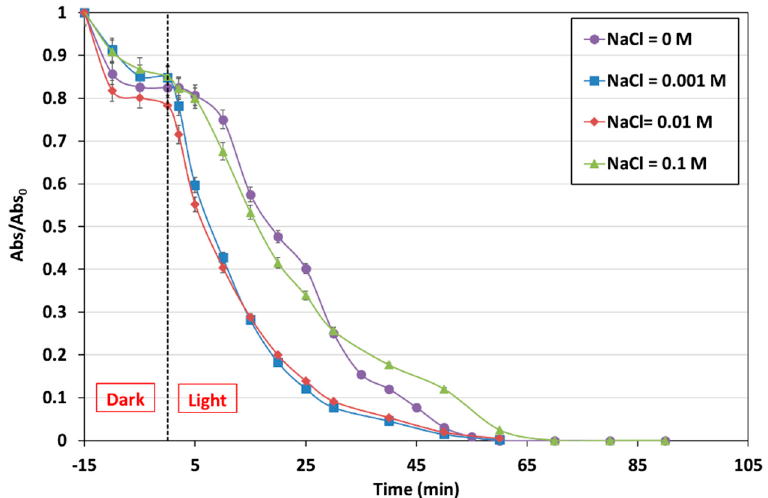
Figure 7. Influence of the aqueous solution salinity in the presence of NaCl ions on the degradation of MB (C 0 = 60 mg/L; pH neutral, D TiO2 = 1 g/L; temperature = 20 ± 2 °C).